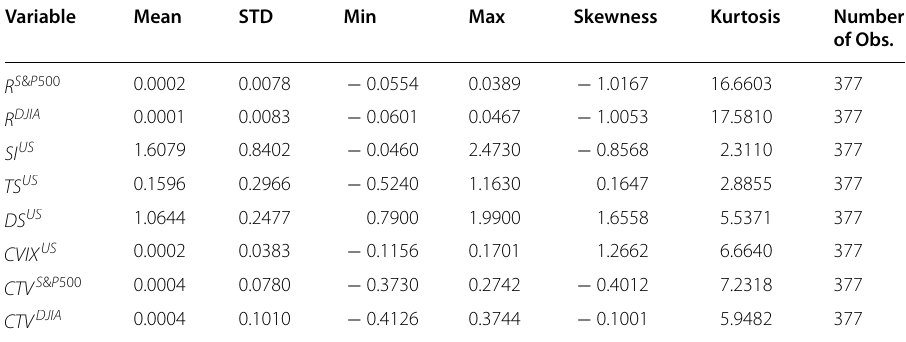
Table 2 Summary Statistics: